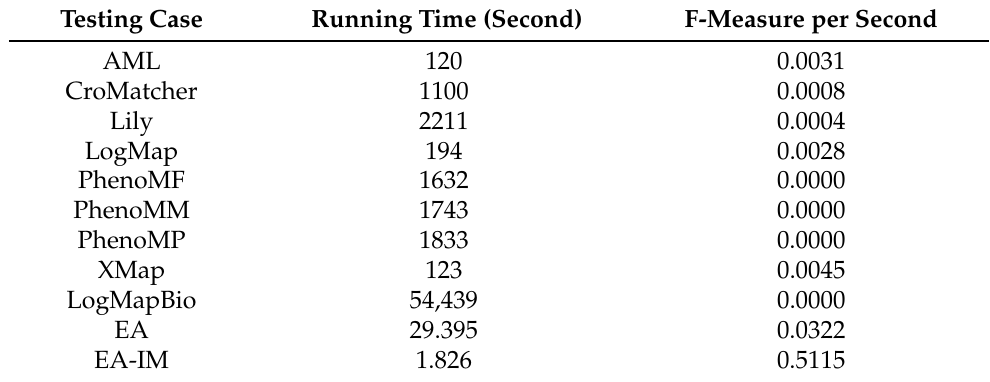
Table 5. Comparison among EA-IM and OAEI’s participants in terms of running